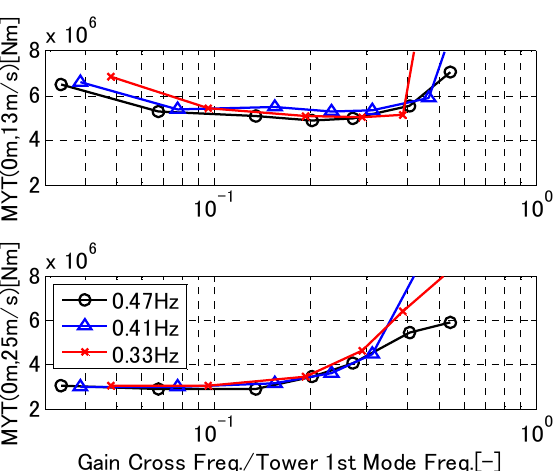
Fig. 11 DELs of Tower Base Bending in 13m/s and 25m/s